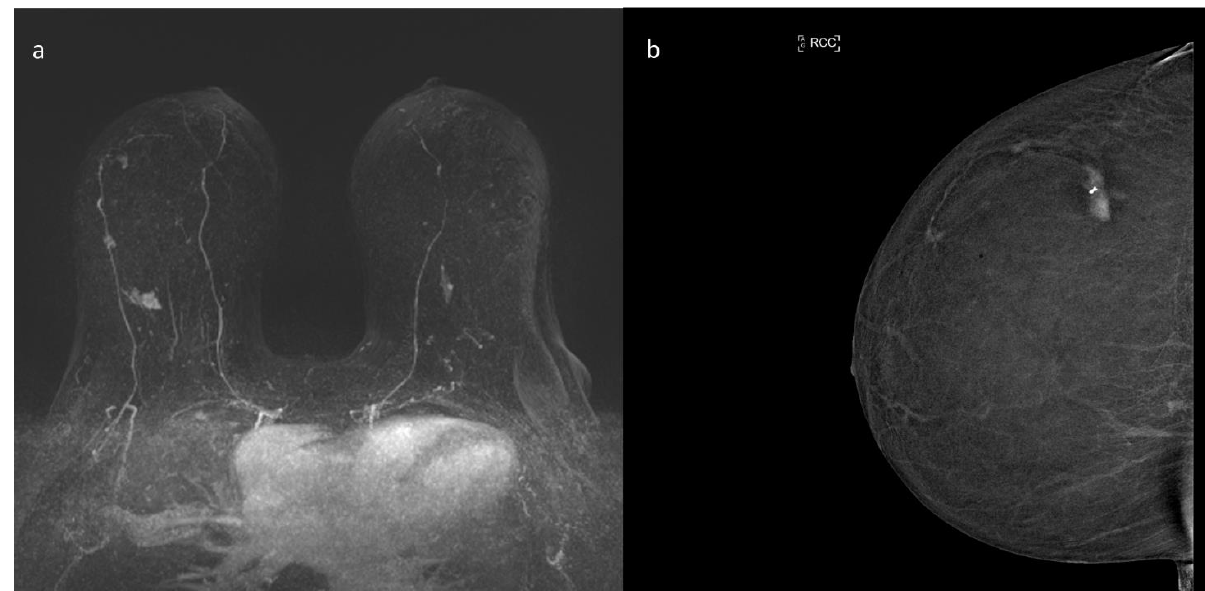
Figure 3. Preoperative staging with functional imaging of a 65-year-old patient with histological diagnosis of invasive multifocal ductal carcinoma of the external central quadrant of the right breast. ( a ) ce-MRI MIP image (maximum intensity projection); there are three irregular masses in the right breast referable to the multifocal index lesion. ( b ) CEM recombined images; in these images there are the three irregular masses referable to the index lesion, perfectly superimposable to that of ce-MRI.